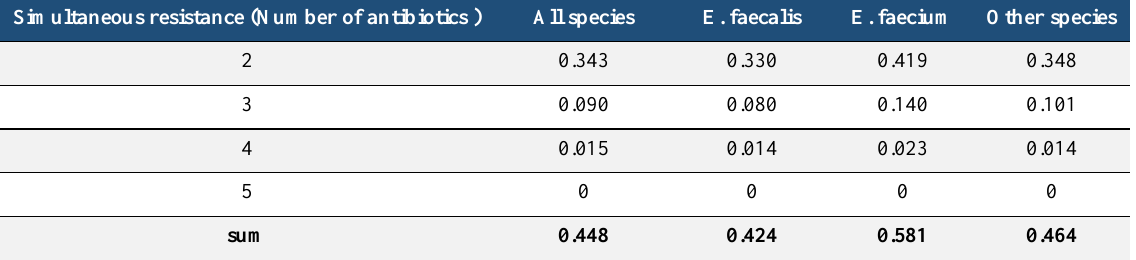
Table 5. The fraction of samples that are simultaneously resistant to two or more antibiotics. The first column shows the number of antibiotics to which there is simultaneous resistance, and other columns show the fraction of all samples or fraction of samples within different species which are resistant to multiple antibiotics simultaneously. The last row is the sum of all rows above it. Simultaneous resistance (Number of antibiotics )